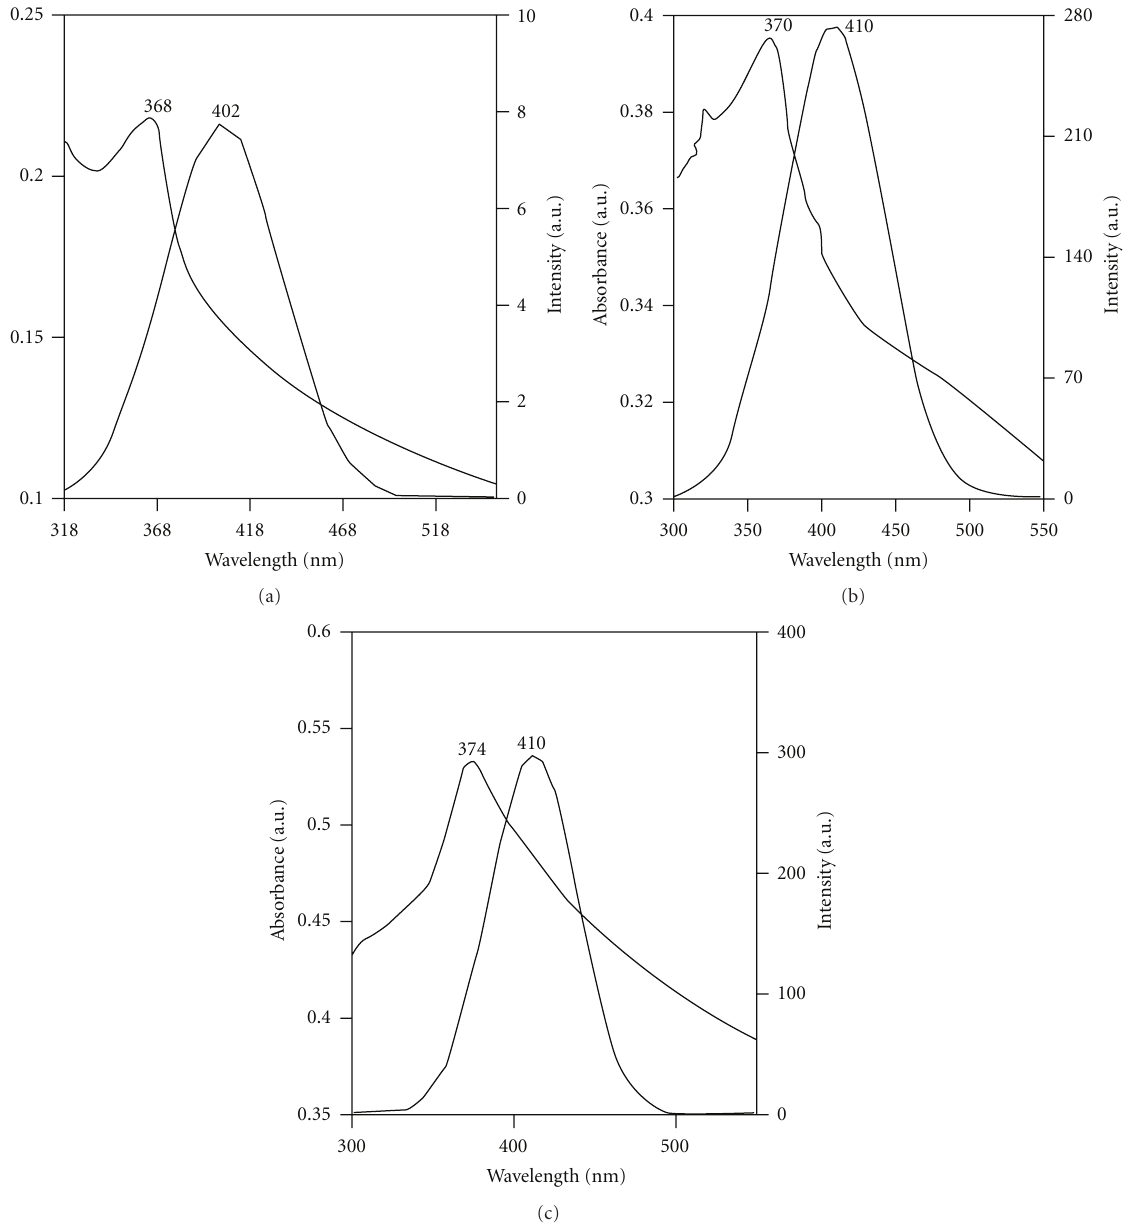
Figure 1: Absorption and emission spectra of ZnO nanoparticles synthesised in ethanol (a), acetone (b), and water (c) at 120 ◦ C and time of 15 minutes under